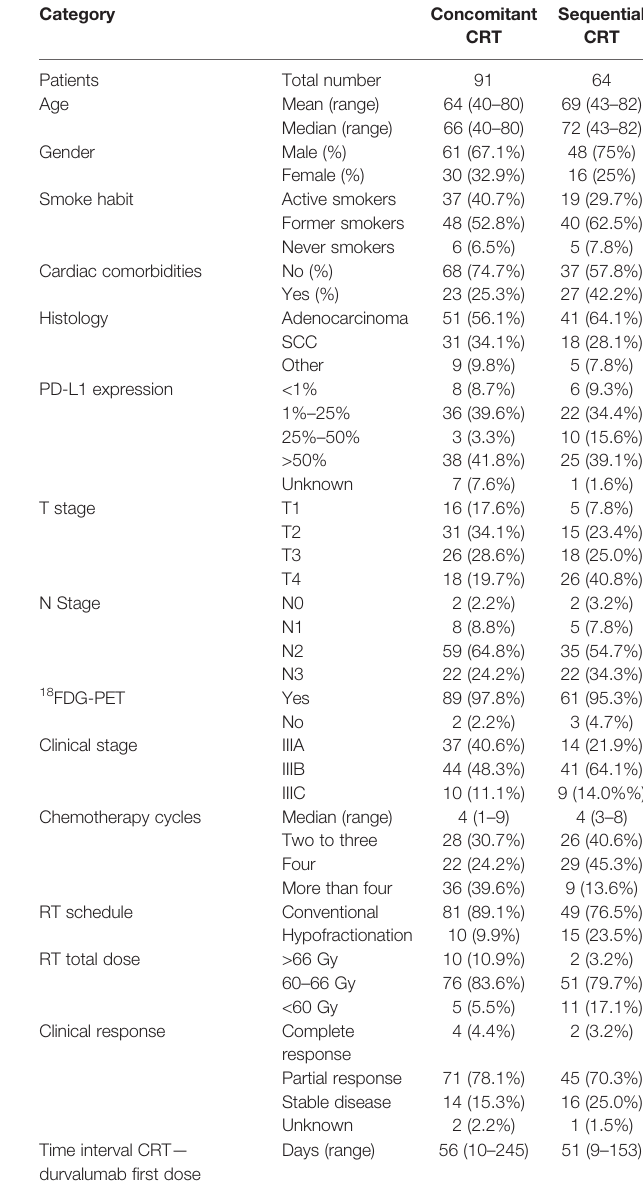
TABLE 2 | Patients ’ characteristics for concomitant vs. sequential